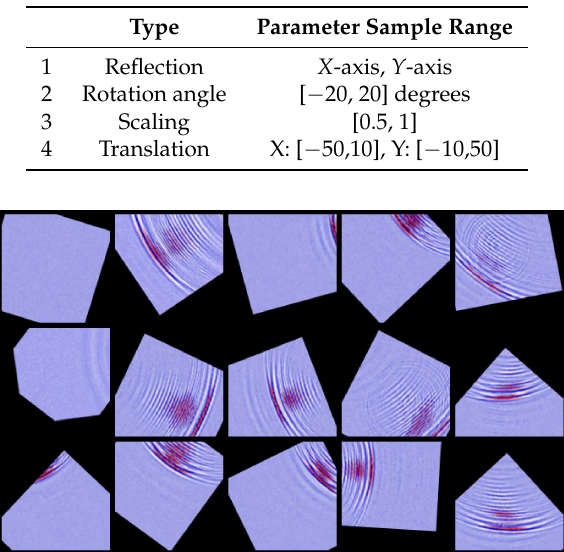
Table 3. Data augmentation scheme.